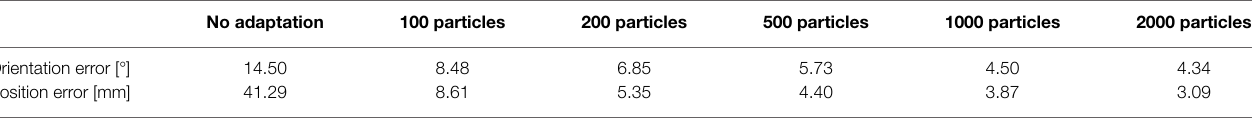
TABLE 2 | Trade-off between number of particles and accuracy of the estimation